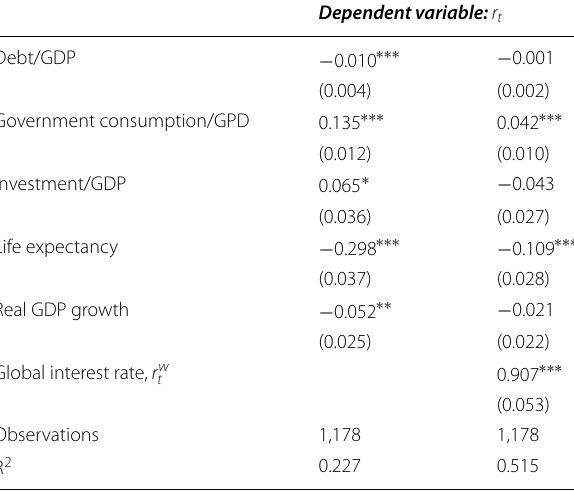
Table 5 Determinant of Real Interest Rates: Panel